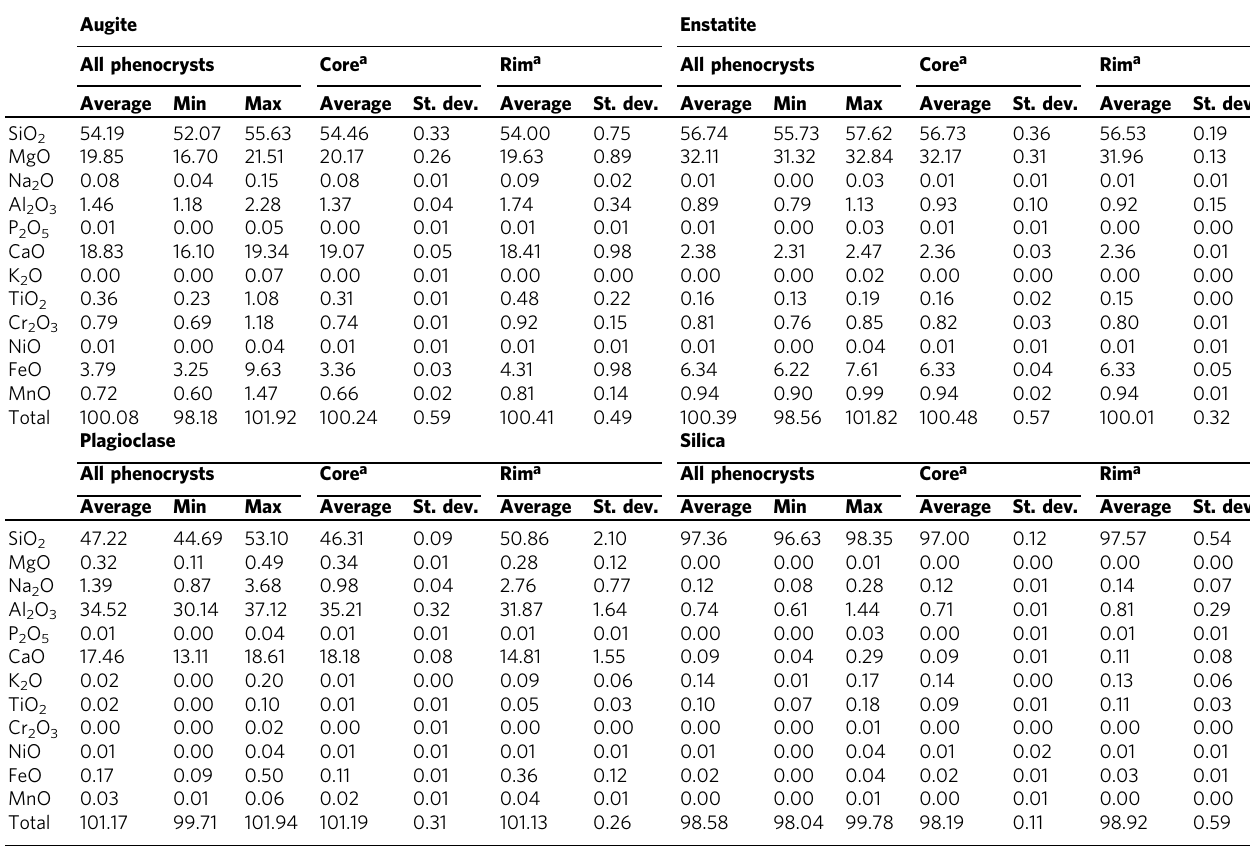
Table 1 Mineral compositions (wt.%) for NWA 11119 determined by EPMA Augite Enstatite All phenocrysts Core a Rim a All phenocrysts Core a Average Min